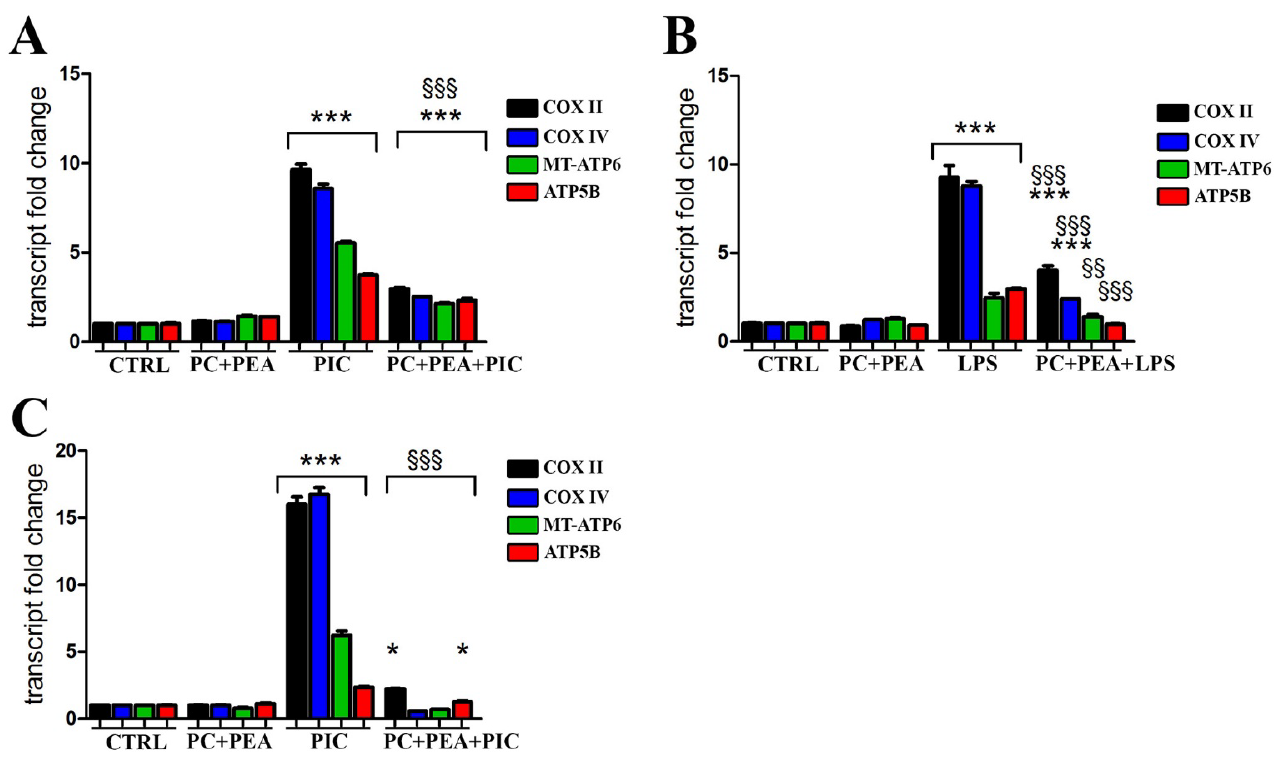
Figure 5. PC and PEA synergically decrease the respiratory burst triggered by the inflammatory stimulus. Cells were treated for 24 h either with 20 µg/mL bacterial antigen lipopolysaccharide (LPS) or with 10 µg/mL Poly(I:C) (PIC), 1 µM PC and 1 µM PEA, alone or in combination. The transcript levels of cytochrome C oxidase subunit 2 (COX II) and subunit 4 (COXIV), and the transcription of two subunits of ATP synthase (MT-ATP6 and ATP5B) were measured by real-time PCR both in Beas-2B ( A , B ) and HPrEpiC ( C ) cells. Control cells (CTRL) were not treated. Results are means ± SEM. * p < 0.05, and *** p < 0.001 vs. ctrl; §§ p < 0.01 and §§§ p < 0.001 vs. PIC or LPS.